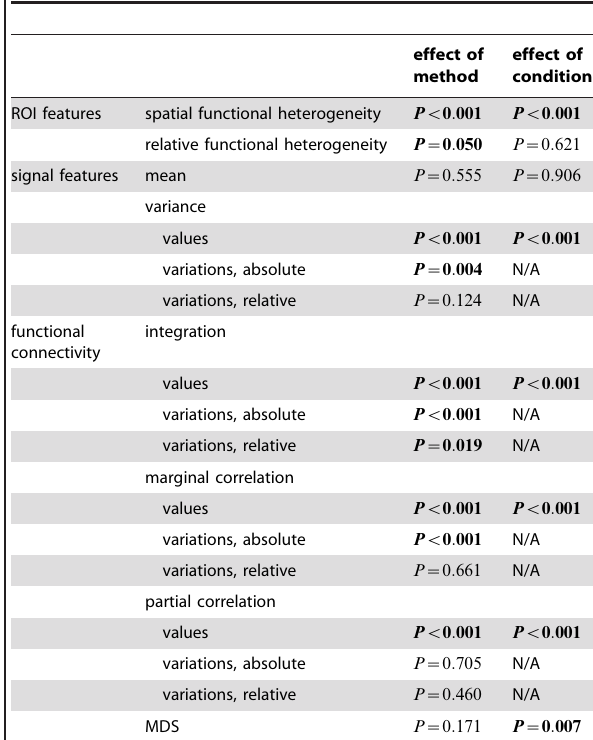
Table 7. Summary of results for an effect of method or condition on the different measures of signal or functional